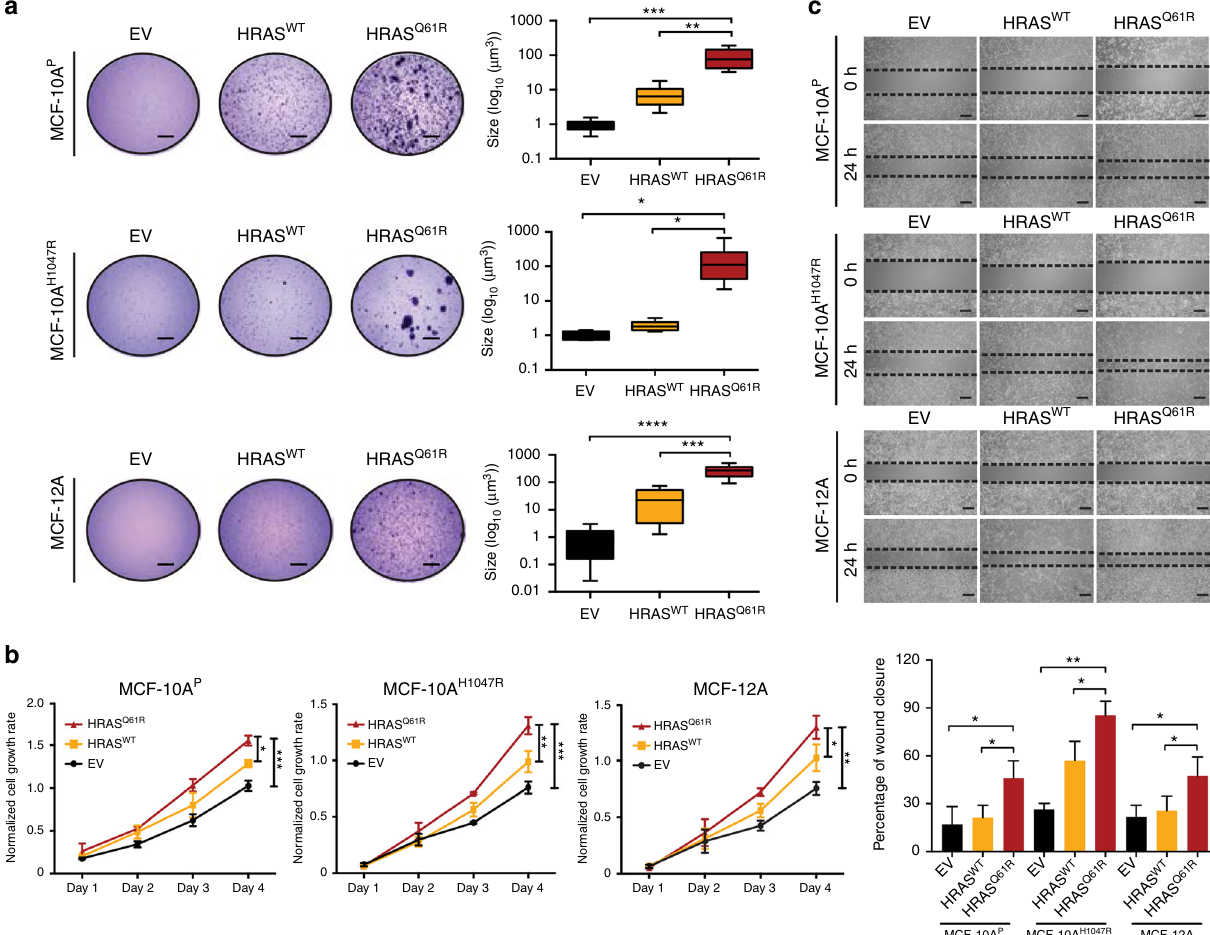
Fig. 5 Mutant HRAS Q61R expression induces transformation and growth in non-malignant breast epithelial cells. a Representative images of soft agar anchorage-independent growth assay of parental MCF-10A PIK3CA -wild-type (MCF-10A P ), MCF-10A PIK3CA H1047R-mutant (MCF-10A H1047R ), and MCF-12A cells stably expressing empty vector (EV), HRAS-wild-type (HRAS WT ), or HRAS Q61R-mutant (HRAS Q61R ) protein (scale bars, 2 mm). Boxplots showing the quanti fi cation of the size of colonies (see Methods). The mean value of the size of colonies, and the 75th and 25th percentiles are displayed at the top and bottom of the boxes, respectively. b MTT cell proliferation assay of MCF-10A P , MCF-10A H1047R , and MCF-12A cells stably expressing EV (black), HRAS WT (yellow), or mutant HRAS Q61R (red) protein. c The migratory effects of MCF-10A P , MCF-10A H1047R , and MCF-12A cells stably expressing EV, HRAS WT , or mutant HRAS Q61R were analyzed using the wound-healing assay at 0 and 24 h. Scale bars, 500 µ m. In a − c , data are representative of three independent experiments. Error bars, s.d. of mean ( n = 3). n.s. = not signi fi cant, * P < 0.05, ** P < 0.01, *** P < 0.001, **** P < 0.0001;